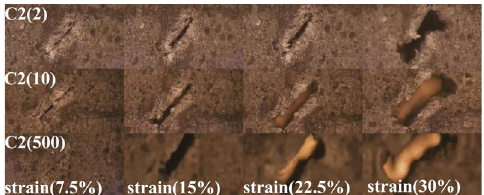
Figure 6: Microphotography (MP) results for group C2 (45 °